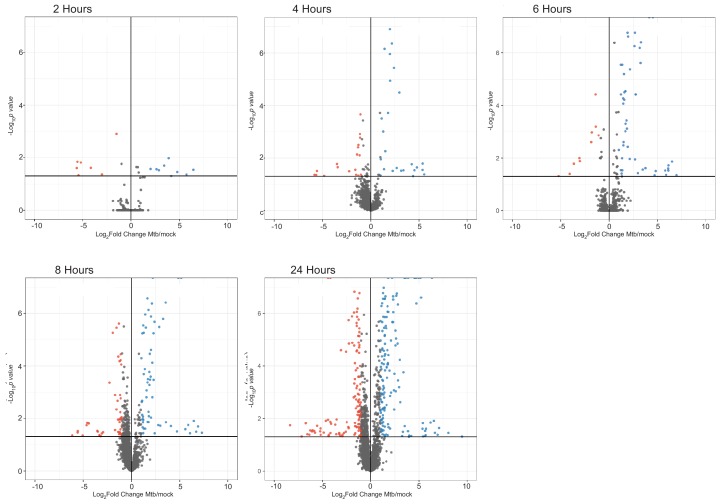
Host protein abundance changes during a time course of Mtb infection.Volcano plots displaying the proteins changing in abundance during Mtb infection. Proteins with a p value less than 0.05 and log2(fold change) greater than one are colored red. Proteins with a p value less than 0.05 and log2(fold change) less than −1 are colored blue.